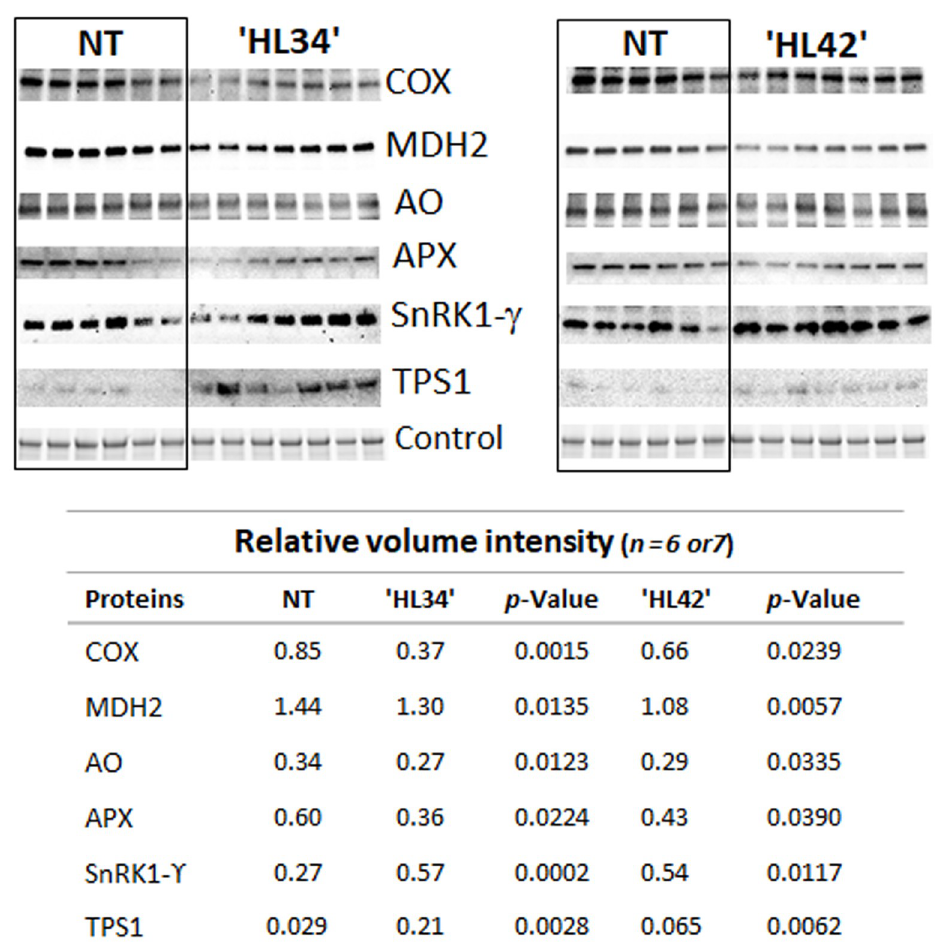
Fig 4. Immunoblot analysis of specific protein abundance in high lipid (HL) Lolium compared with non- transformant (NT) control. Abbreviations: Cytochrome c oxidase (COX, XP_015648280.1); malate dehydrogenase 2 (MDH2, XP_015621604.1); L-ascorbate oxidase (AO, XP_015611052.1); L-ascorbate peroxidase (APX, XP_015630498.1); sucrose-nonfermented related protein kinase 1 subunit gamma (SnRK1- γ , XP_015635849.1); and trehalose-6-phosphate synthase 1 (TPS1, XP_015640390.1).